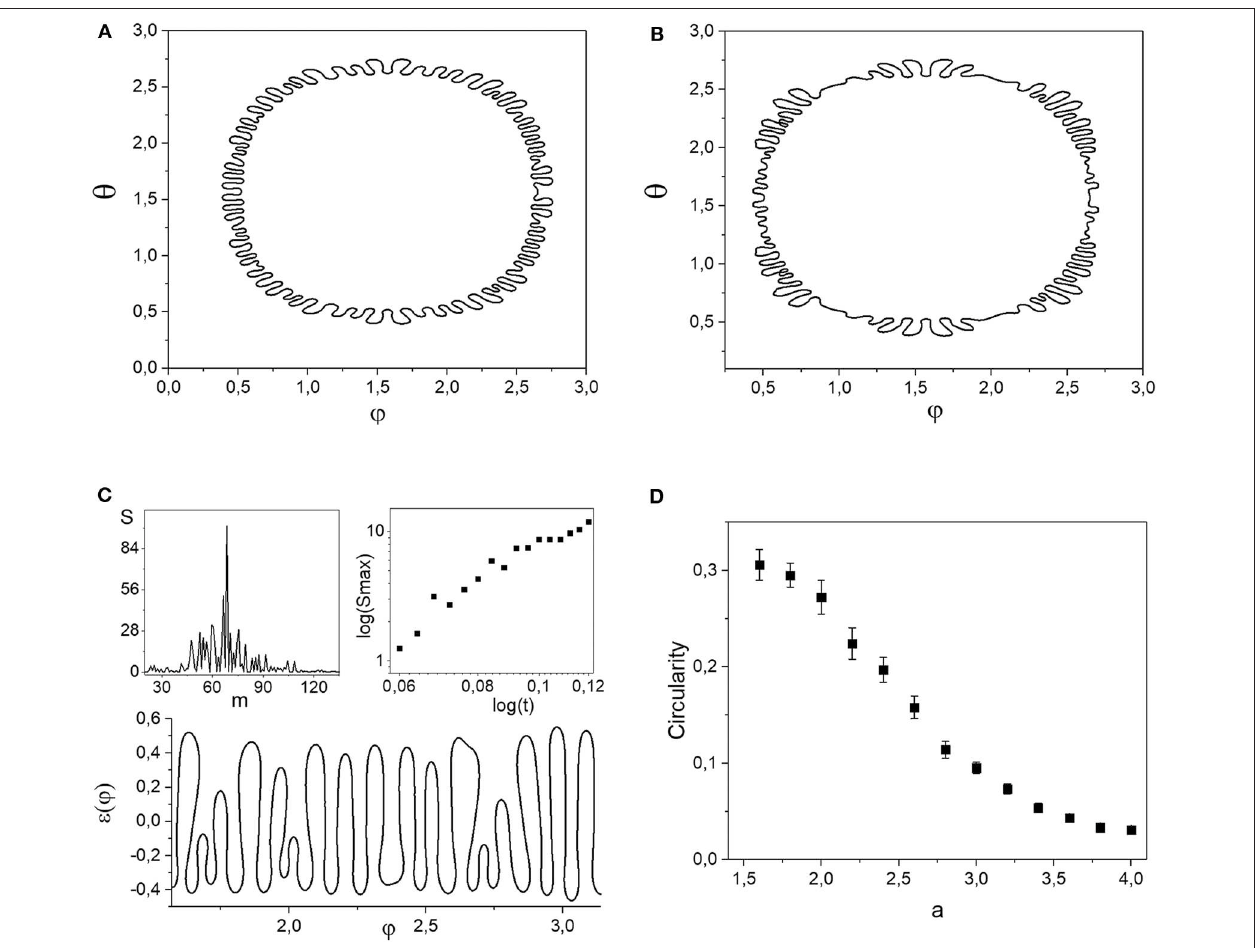
FIGURE 8 | Interface analysis of crystal growth. This figure shows the analysis of the interface of a growing nuclei. Panels (A,B) correspond to the crystal interface of isotropic and six-fold symmetry, respectively, as seen in the θ t 0.056 (below), the structure factor of this interface configuration (upper left), and the exponential growth of the peak of the structure factor (upper right). Panel (D) = shows the circularity of the growing nuclei for a spherical substrate of different radius a , as obtained by the numerical solution of the interface model ( t α β γ = = =